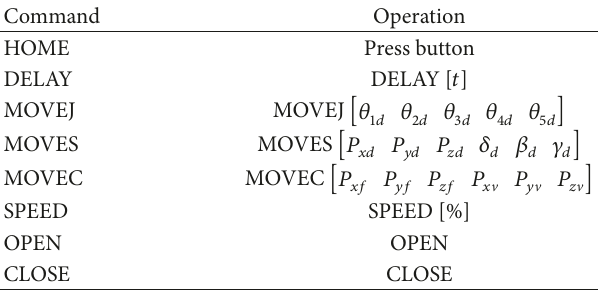
Figure 14: Enter orders to execute. Table 1: Commands